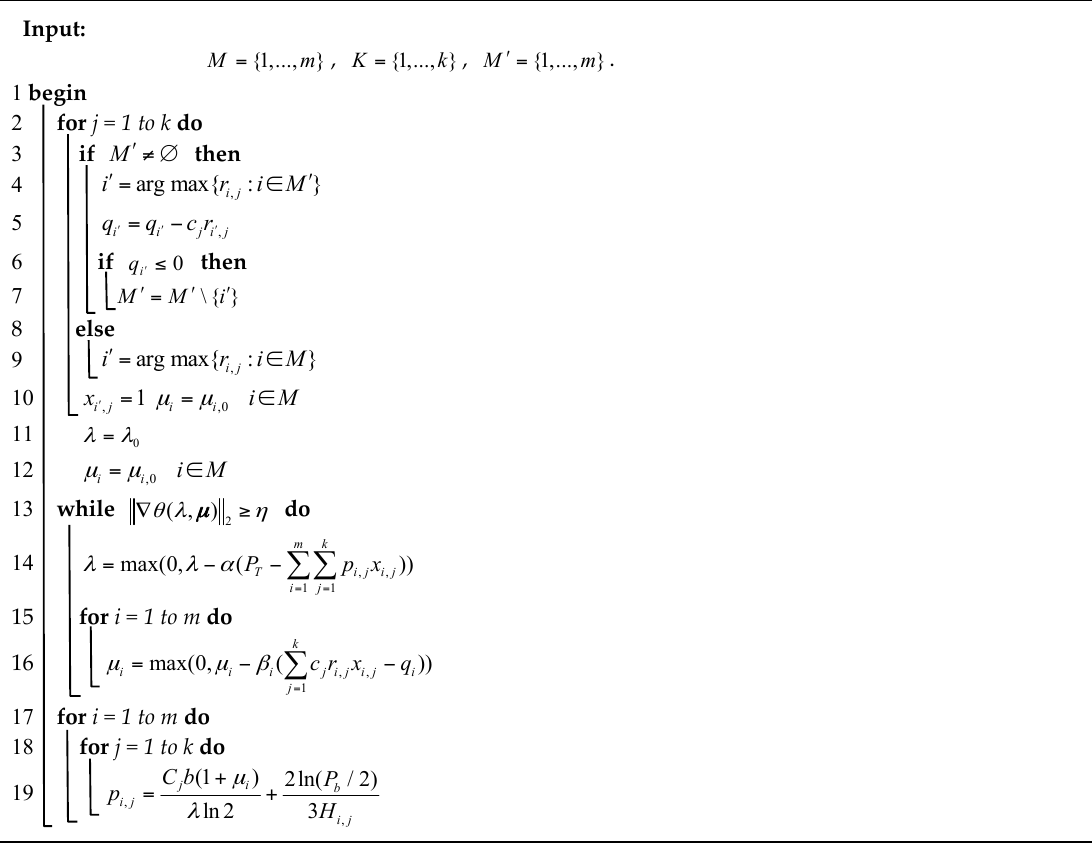
Algorithm 1: The pseudocode for solving algorithm: two step solving algorithm